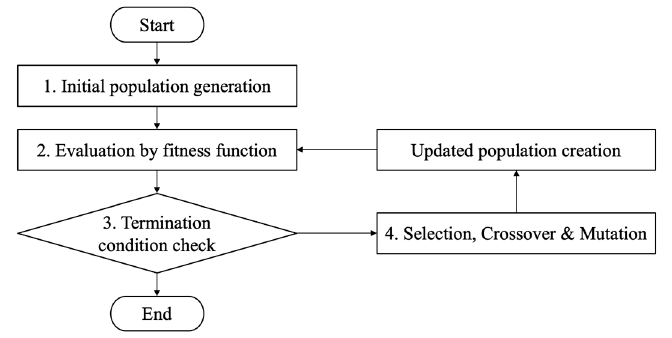
Figure 4. The overall process of the genetic algorithm.